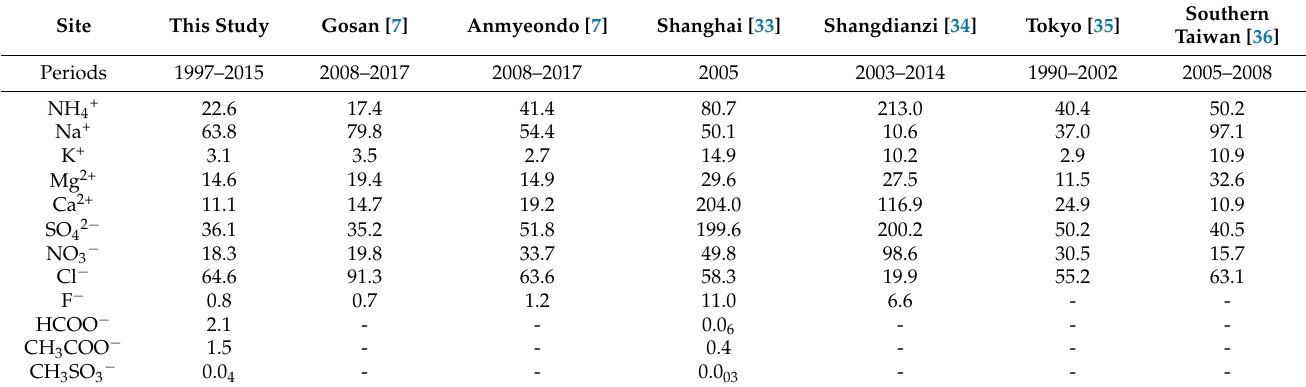
Table 3. Volume-weighted mean ionic concentration ( µ eq/L) of precipitation in the other sites.